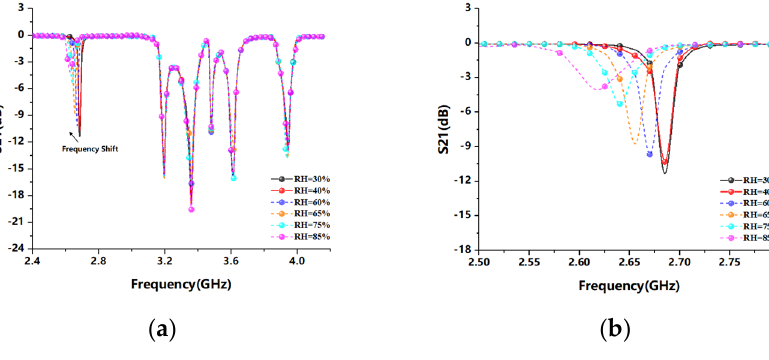
Figure 11. Resonant response of CSRR humidity sensor unit: ( a ) Changes in the overall S21 resonant response curve of the tag sensor; ( b ) Changes in the S21 curve of locally amplified CSRR resonant element; ( c ) Linear fitting line of relative humidity of CSRR resonant element.